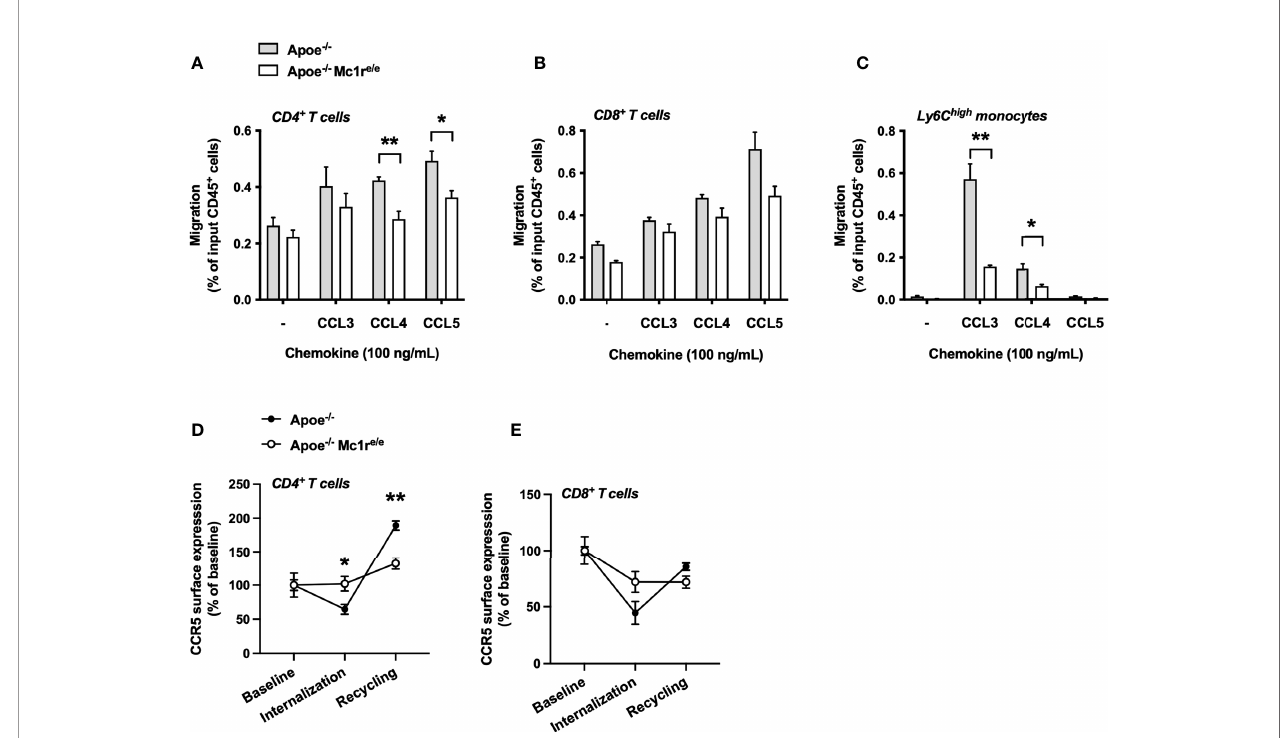
FIGURE 6 | MC1-R de fi cient CD4 + T cells show impaired CCR5-dependent migration and recycling of the CCR5 receptor. (A – C) Transwell migration assay using splenocytes from Apoe -/- and Apoe -/- Mc1r e/e mice. Cell were allowed to migrate for 3 hours towards the indicated chemokines and migrated CD4 + T cells, CD8 + T cells and Ly6C high monocytes were quanti fi ed by fl ow cytometry as percentage of input CD45 + cells. n=4 mice per genotype (D, E) Quanti fi cation of CCR5 surface expression on CD4 + cells and CD8 + T cells that were isolated from Apoe -/- or Apoe -/- Mc1r e/e mice. CCR5 surface expression was quanti fi ed during baseline, after CCL5-induced internalization and after withdrawal of CCL5. n=4 mice per genotype. Data are mean ± SEM., *P < 0.05, **P < 0.01 versus Apoe -/-